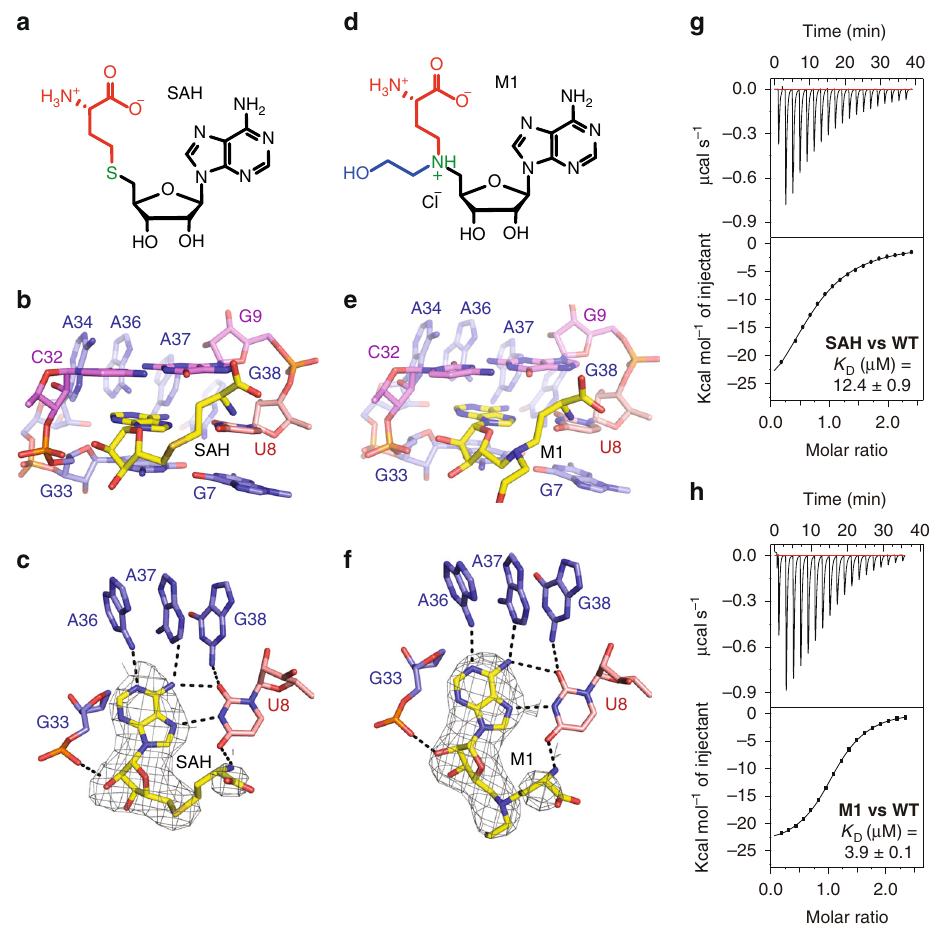
Fig. 3 Structures of SAM-VI riboswitch bound to non-cognate SAH and a ligand mimic. a Chemical structure of SAH. b SAM-VI binding pocket interactions with SAH (for discussion see main text). c Detailed view of the SAH-adenine U8 base pair. The composite omit electron-density map of SAH contoured at the 1.0 σ level is shown in light gray. d Chemical structure of the ligand mimic (M1). e SAM-VI binding pocket interactions with M1 (for discussion see main text). f Detailed view of the M1-adenine U8 base pair. The composite omit electron-density map of M1 contoured at the 1.0 σ level is shown in light gray. g , h Exemplary ITC titration experiments of SAM-VI riboswitch binding with SAH and the ligand mimic M1, respectively; for arithmetic means of K d values and thermodynamic parameters see Table 1 and Supplementary Table